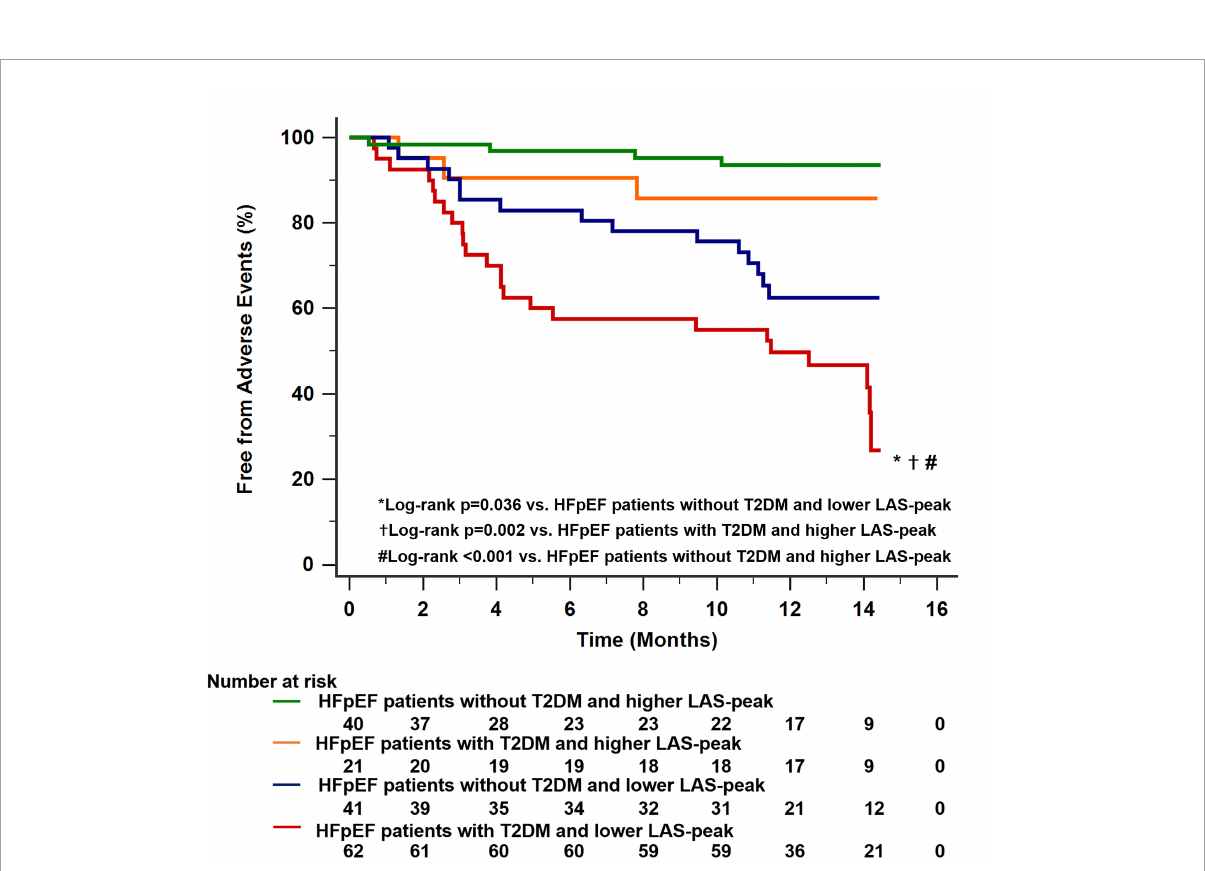
FIGURE5 Dividing all HFpEF patients into two main groups using the median value of LAS-peak (27.2%) identified 40 patients with HFpEF with T2DM and low LAS-peak. This characteristic was associated with worse long-term outcomes compared with the other subgroups. HFpEF, heart failure with preserved ejection fraction; LAS, left atrial strain; T2DM, type 2 diabetes